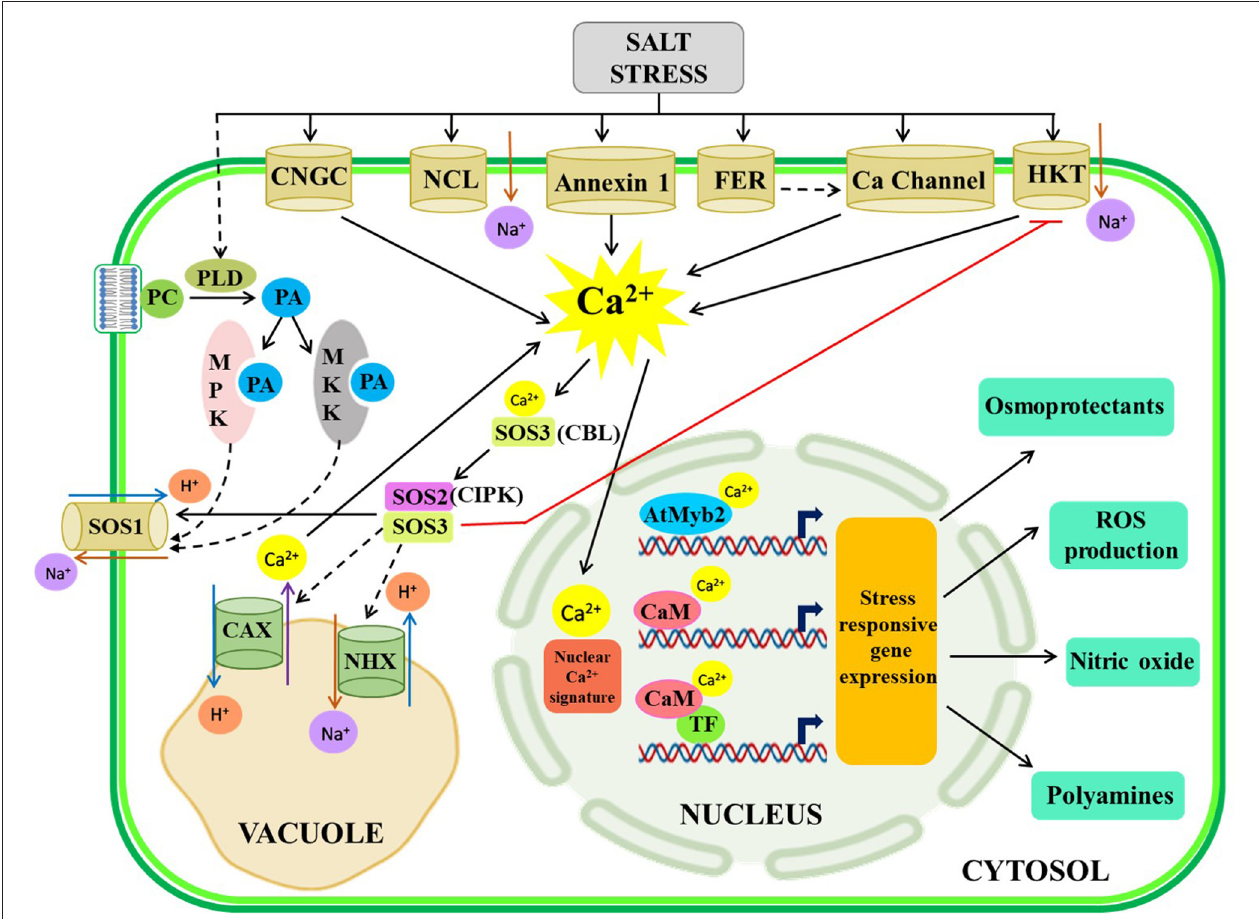
FIGURE 1 | Illustrative representation of crosstalk among Ca 2 + signaling components under the salt-stressed condition. During the salt-stressed condition, Na + is transported into the cytoplasm through different plasma membrane-localized channels leading to a spike in [Ca 2 + ] cyt , which activates SOS pathway and PA-mediated signaling, necessary for extrusion of Na + from the cytosol to the vacuole and extracellular space and subsequent stress-responsive gene expression for production of osmoprotectants, ROS, nitric oxide, and polyamines. The solid arrow represents direct activation; the dotted arrow represents indirect activation via some intermediates. NCL-Na + /Ca 2 + exchanger like protein, HKT, high-affinity K + transport, FER-FERONIA, PCphosphatidylcholine; SOS, salt overlay sensitive; ROS, reactive oxygen